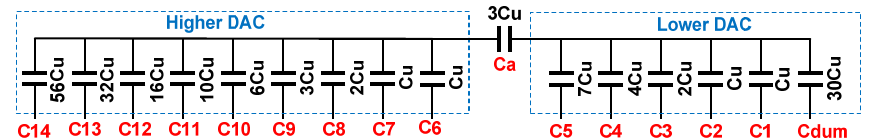
Figure 9. Binary-scaled recombination method in the bridge structure.